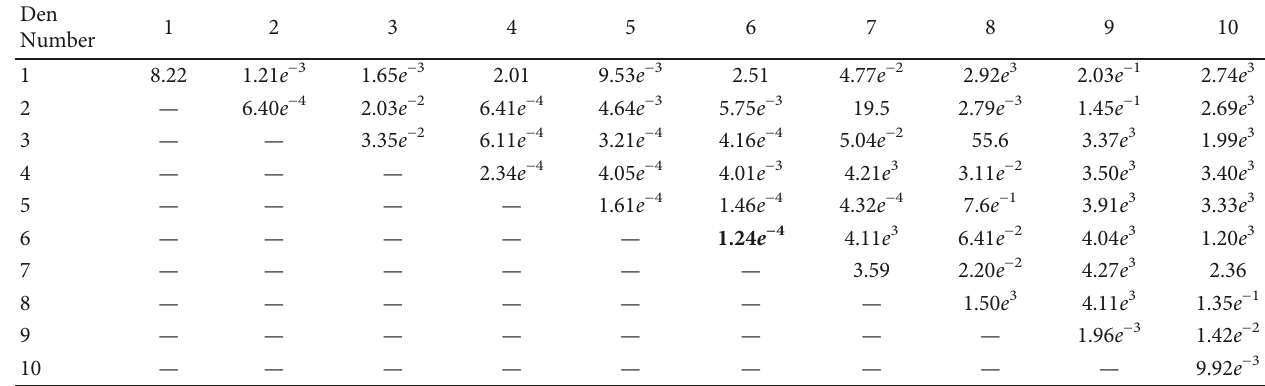
Table 1: MSE between real outputs and identi fi ed systems